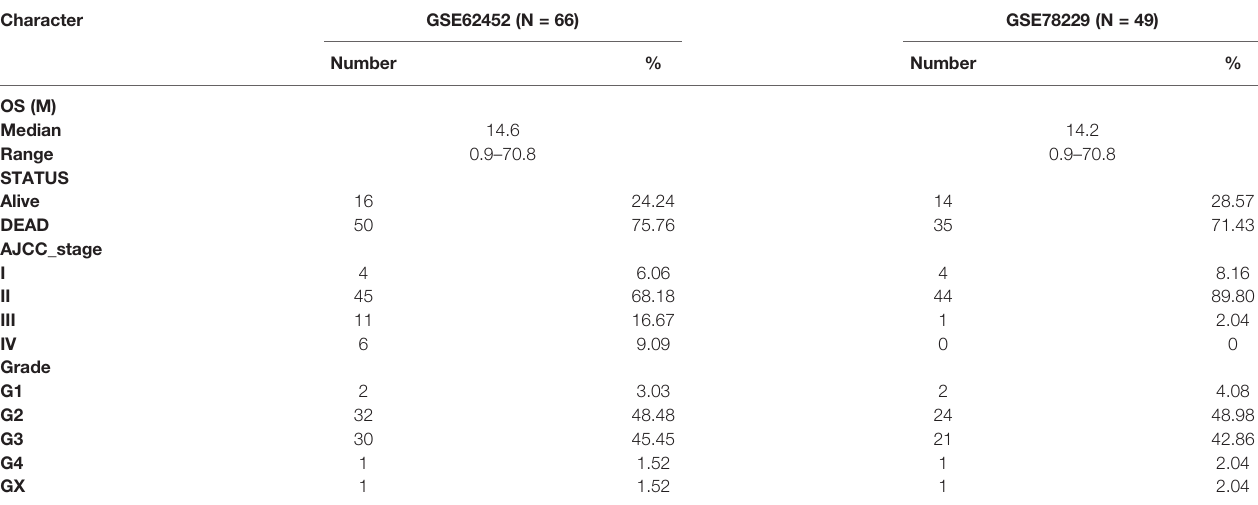
TABLE 2 | Clinical and pathologic information of GSE62452 and GSE78229 dataset.